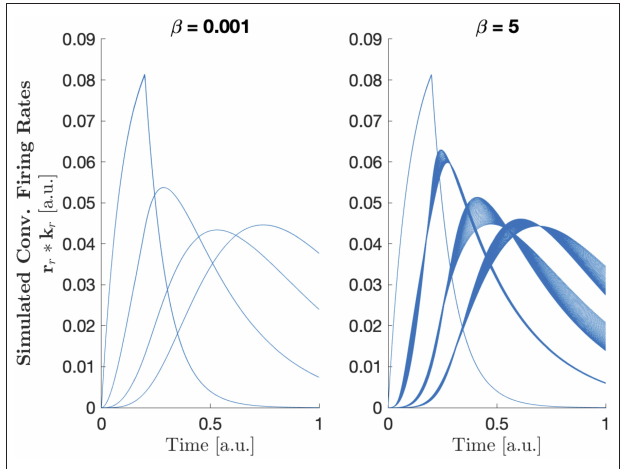
FIGURE 6 | Normalized convolved firing rates from all trials with F ( x ) = 1 + b and β = 0.001 (left) and β = 5 (right). β ( x − a ) tanh β (cid:0) (cid:1)